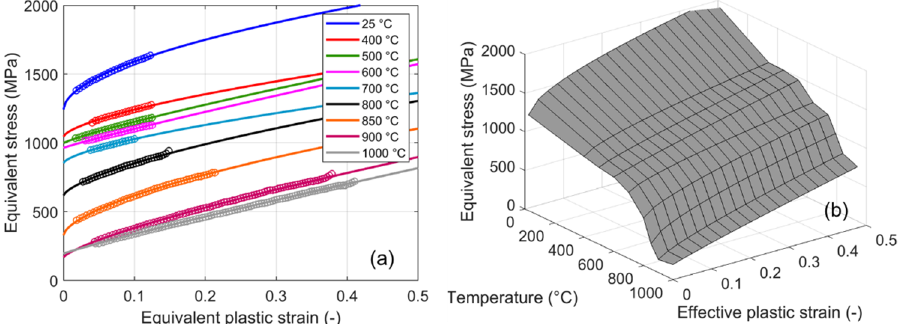
Figure 15. HT specimens: ( a ) comparison between the experimental results in terms of equivalent stress versus equivalent plastic strain obtained from the engineering data (markers) and the fitting models (lines); ( b ) surface obtained for the definition of the high strain rate material response as a function of equivalent plastic strain and